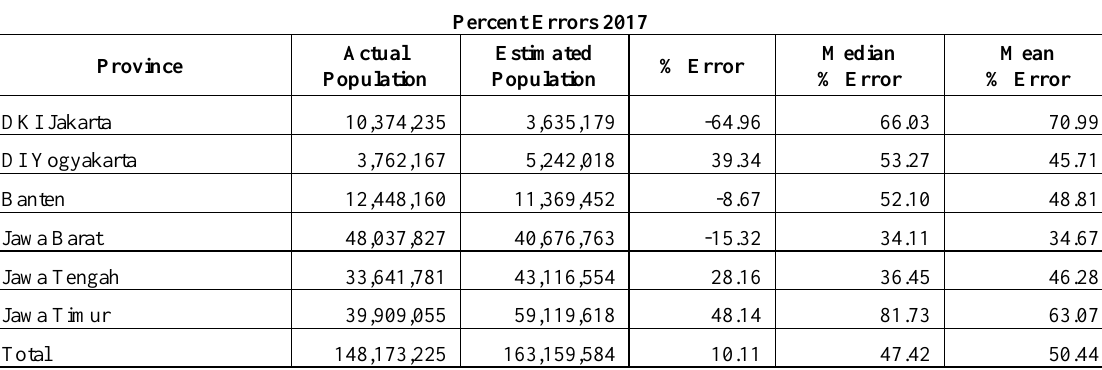
Table 4. Percent errors of the 2017 population estimates per province.